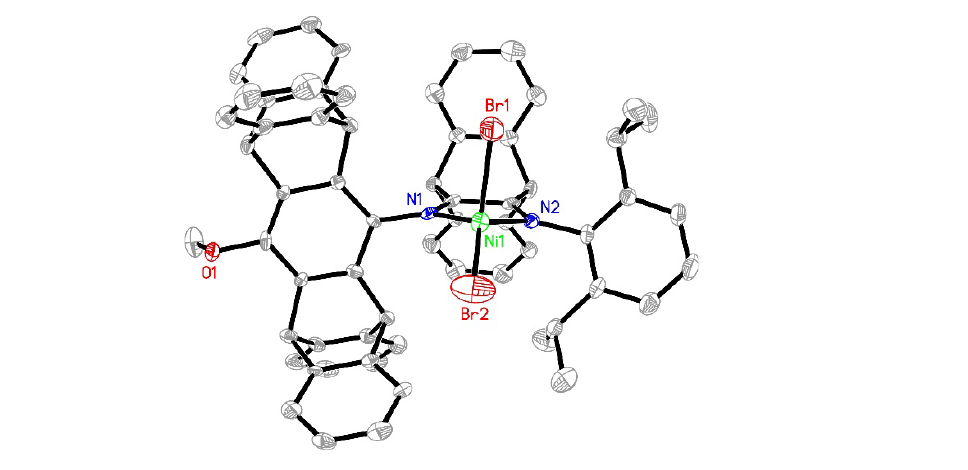
Figure 1. Molecular structure of Ipty/ i Pr-Ni drawn with 30% probability ellipsoids. Hydrogen atoms are omitted for clarity. Selected bond lengths (Å): Ni1–Br1 2.360(2), Ni1–Br2 2.273(3), Ni1–N1 2.027(8), Ni1–N2 2.034(9).